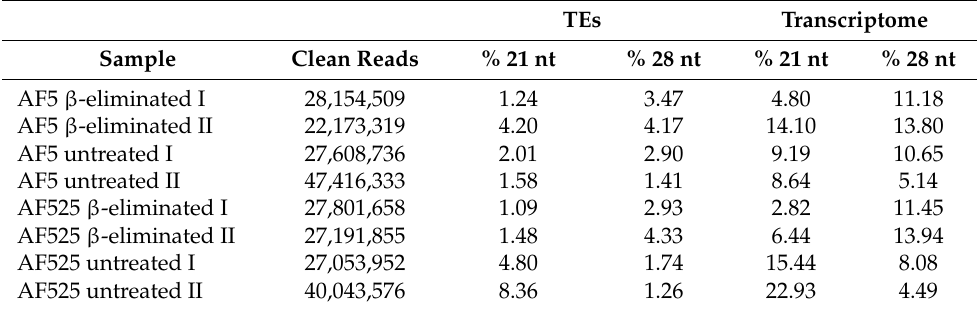
Table 3. Analysis of β -eliminated small RNA samples mapping to transposable elements of the AF5/AF525 genome and the Ae. aegypti transcriptome. Total number of clean reads is listed for each sample as well as the percentage of total reads of 21 nt (% 21 nt) and 28 nt long RNAs (% 28 nt) mapping to TEs and the share of those RNAs mapping to the transcriptome of the cell. Small RNAs of 21 nt are used as a representative for siRNAs and 28 nt long reads as a representative for piRNAs. Data from two independent sequencing runs are